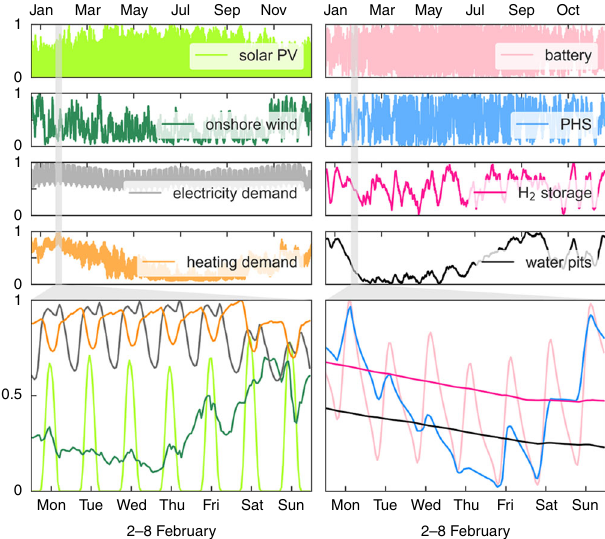
Fig. 7 Time series for the Europe-aggregated demand, generation and storage technologies dispatch for the Early and Steady path in 2050. The bottom fi gures depicts the system operation throughout one of the most critical weeks of the year (comprising high heating demand, low wind and solar generation). Hydrogen storage discharges and fuel cells help to cover the electricity de fi cit, hot water pits in district heating systems discharge stored thermal energy to supply heat